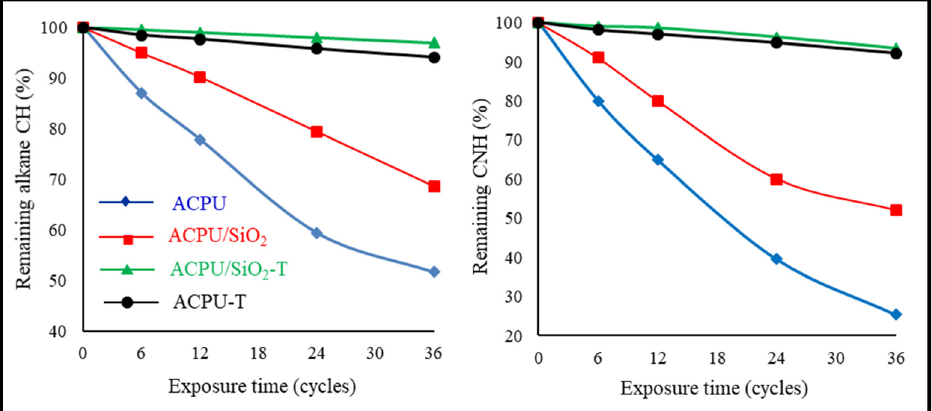
Figure 5. Chemical changes of the alkane CH ( left ) and CNH ( right ) groups in the various coatings under accelerated weathering condition.